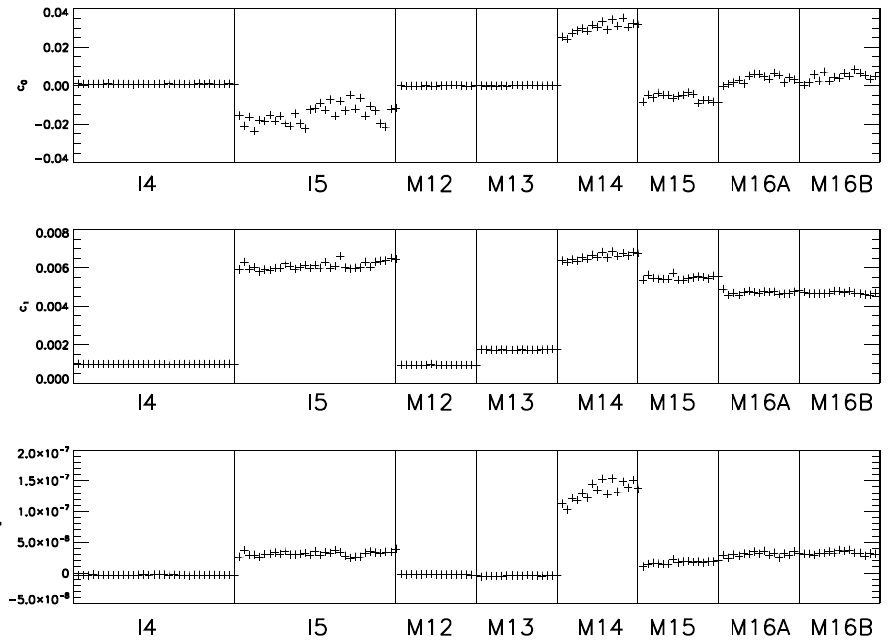
Figure 3. JPSS-3 VIIRS TEB coefficients for all detectors. Only high gain is